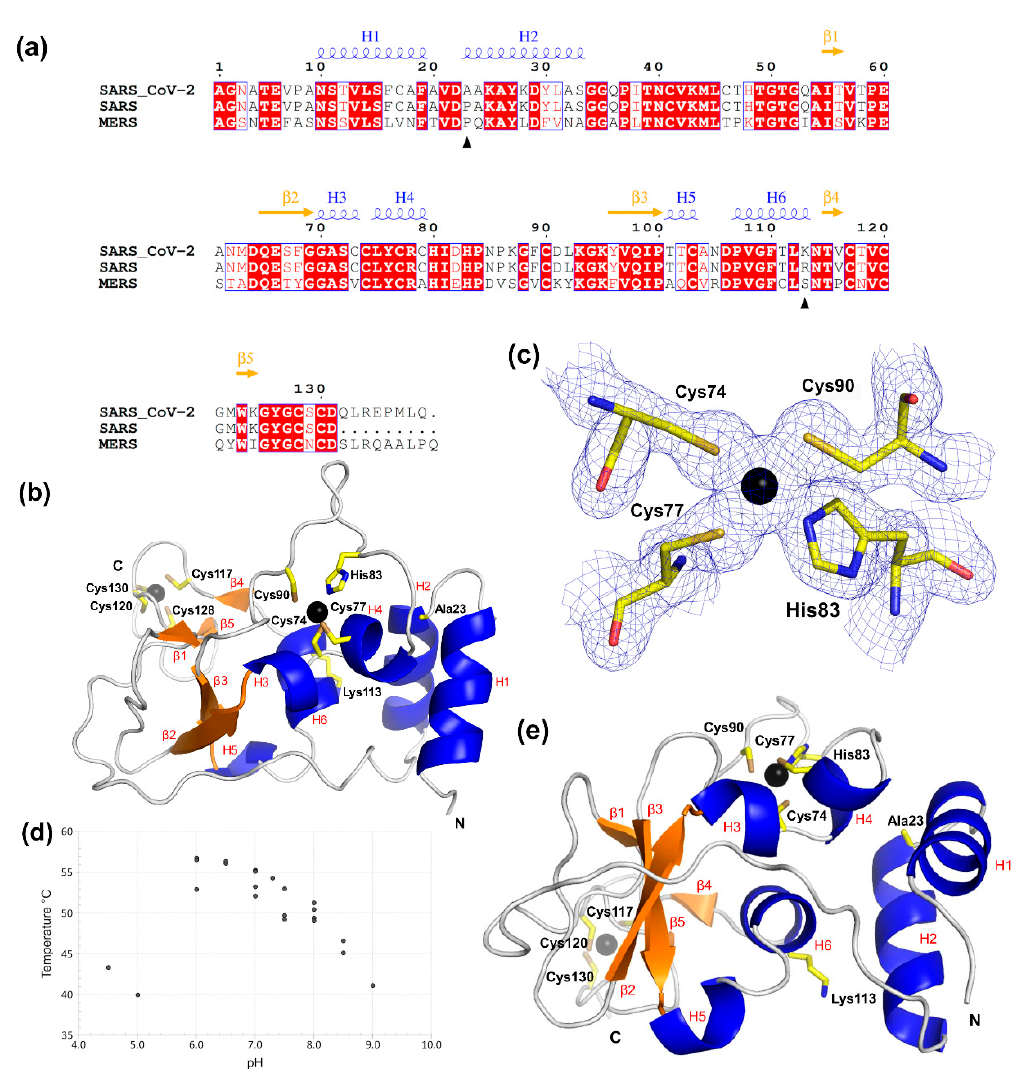
Figure 1. Overall structure of SARS-CoV-2 nsp10. ( a ) Alignment of nsp10 full-length protein sequences from MERS, SARS and SARS-CoV-2. Residues shaded in red are fully conserved, while residues with text in red indicate a change to a similar residue. Unshaded amino acids in black indicate non-conserved residues. The black arrows show the two residues that are di ff erent between SARS and SARS CoV-2. Figure was generated using ESPript, and the secondary structure elements were identified by STRIDE for nsp10 from SARS CoV-2 and are shown above the alignment [24,25]. ( b ) Illustration of nsp10 (cid:48) s overall structure with the two zinc fingers shown as a ball-and-stick model. Zn ions are shown as black spheres, and β -sheets and helices, assigned by STRIDE, are coloured orange and blue, respectively [25]. ( c ) The first zinc-finger motif in nsp10 from SARS-CoV-2. The 2F o -F c electron density map is shown for this zinc site in blue mesh, contoured at 1.5 σ . Zinc-coordinating residues are labelled, and the zinc ion is shown as a black sphere. ( d ) Scatterplot of nanoDSF data. Nsp10 unfolding temperature T m as a function of pH. ( e ) Residues that di ff er from SARS-CoV—Ala23 and Lys113—and cysteine and histidine side chains involved in the coordination of the zinc fingers are also shown as ball-and-stick models. N- and C-termini are indicated as single letters in black.